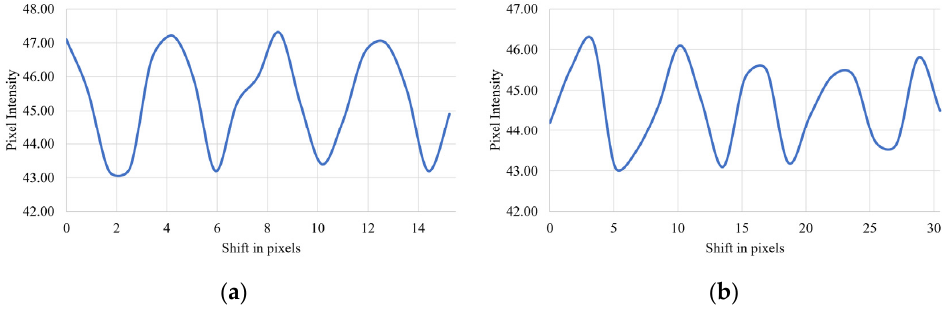
Figure 7. System throughput represented by integrated pixel intensity as a function of lateral shift of the Talbot image by tilting mirror M1 for grating period of ( a ) 4 pixels and ( b ) 6 pixels. The signal exhibits periodic oscillation with periodicity of 4 and 6 pixels.